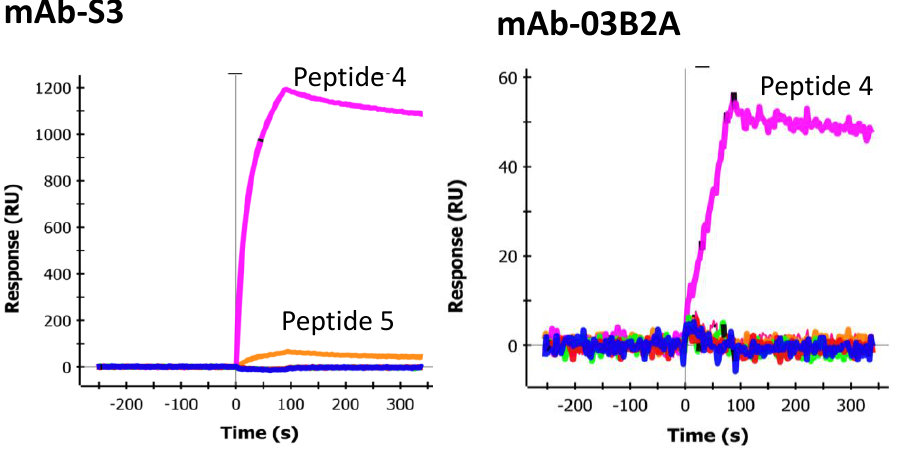
Figure 7. Binding of mAb-S3 and mAb-03B2A to selected peptide fragments of SEB. mAb-S3 generates a robust signal and is thought to recognize a denatured linear